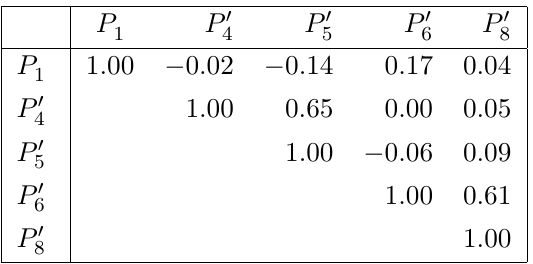
Table 15 . Statistical correlation matrix for the P (